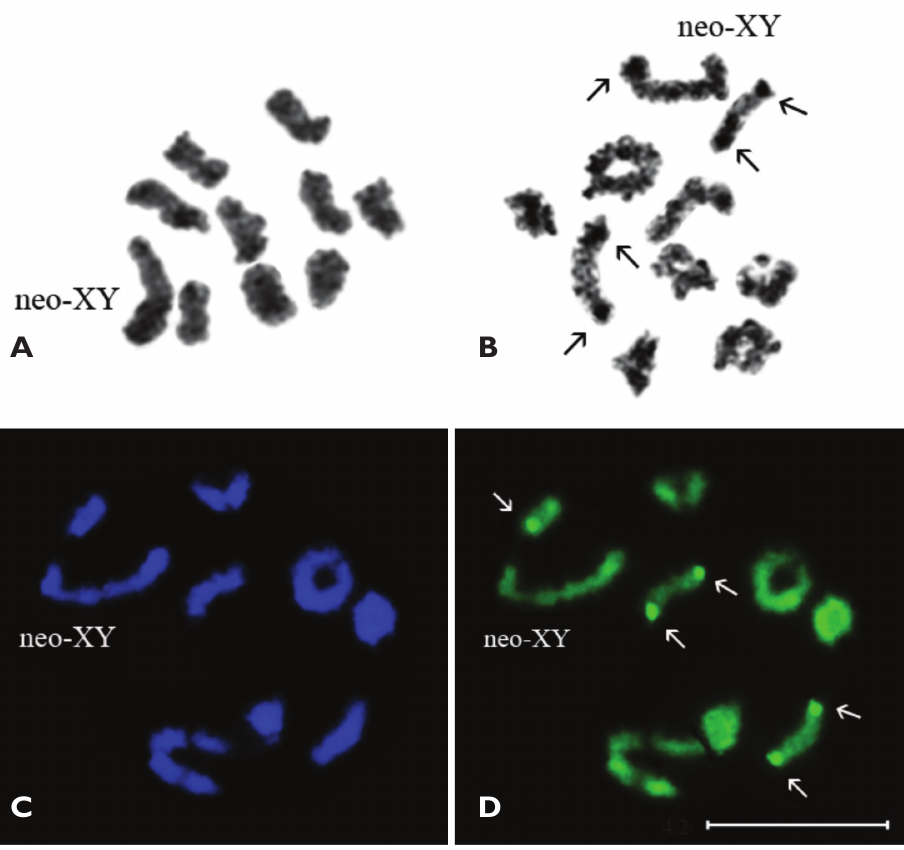
Figure 1A–D. Acmaeodera pilosellae persica , n=9AA+ neo-XY. A prometaphase I/metaphase I B late diakinesis (Ag-banding) C prometaphase I (DAPI staining) D (CMA